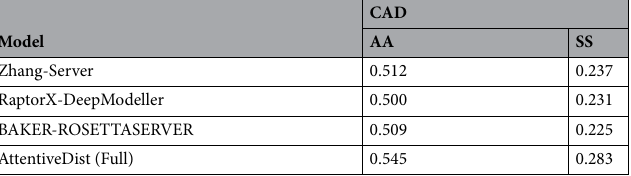
Table 4. Average CAD score of top 1 predicted PDB for the 43 CASP13 FM and FM/TBM domain targets. In AA all residue atoms are taken into consideration, while in SS only sidechain atoms are taken into